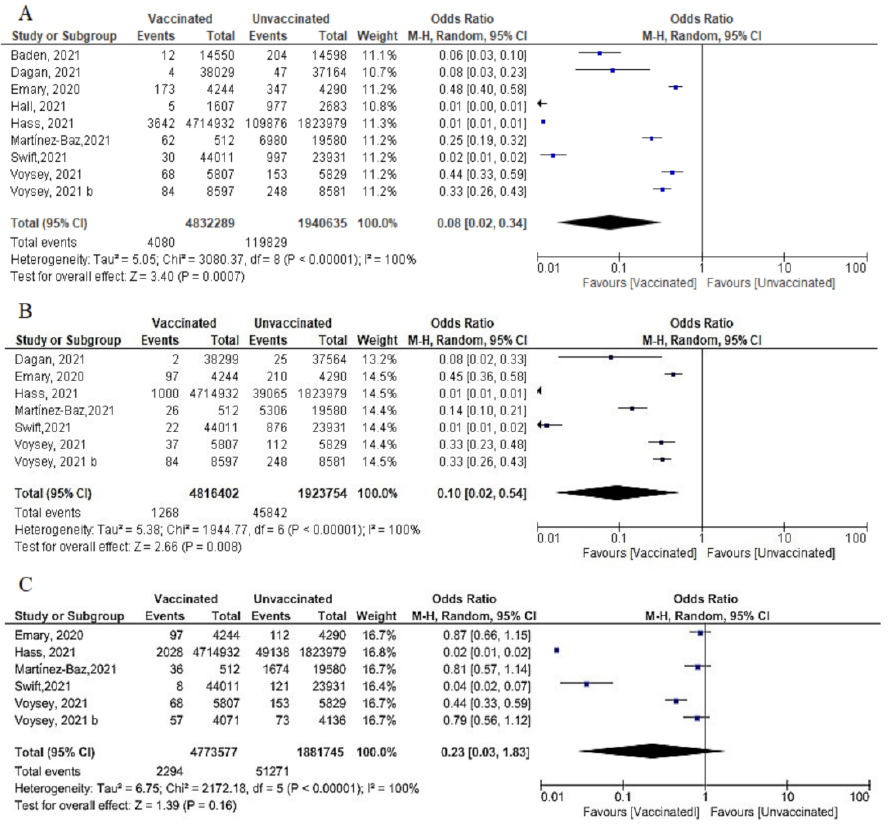
Figure 12. ( A ) Incidence of SARS-CoV-2 infection either symptomatic or asymptomatic after 14 days of 2nd dose of vaccination. ( B ) Incidence of symptomatic SARS-CoV-2 after 14 days of 2nd dose of vaccination. ( C ) Incidence of asymptomatic SARS-CoV-2 after 14 days of 2nd dose of